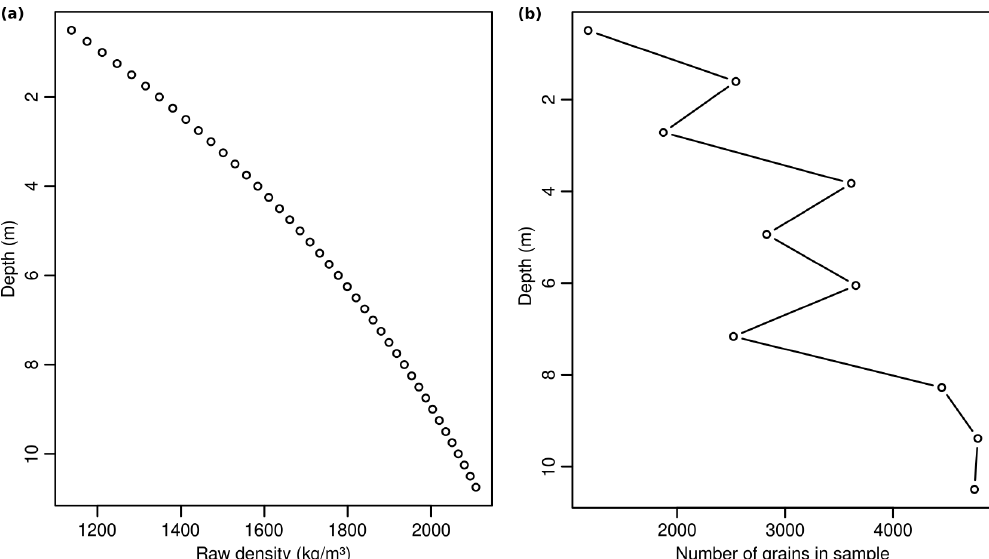
Figure 6. Depth-dependent sediment packing density evolution and resulting effects of generated samples. (a) Exponential relationship of depth and packing density following the model by Sheldon and Retallack (2001) with a decisively high compaction rate of 10 − 1 . (b) Re- sulting increasing number of grains per equally large sample containers (2m sampling interval), showing some scatter due to the also depth-dependent contribution of populations of different size.